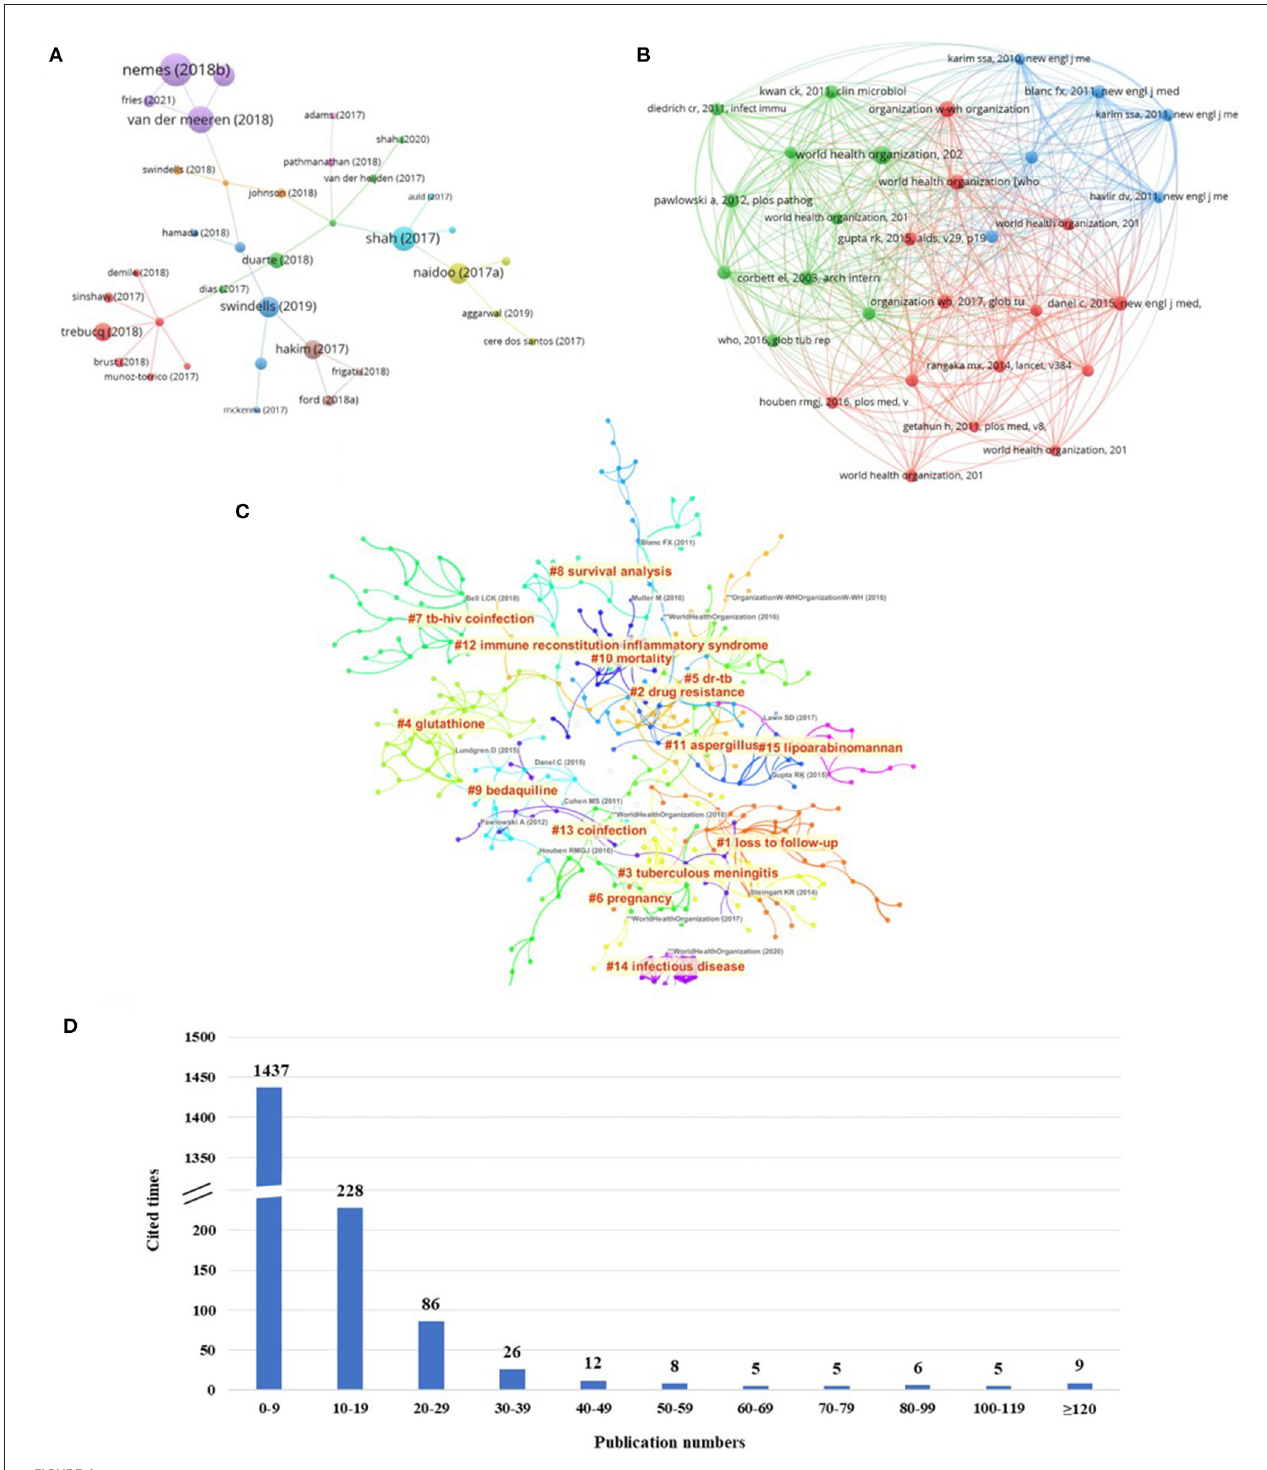
FIGURE4 Reference citations and RCA of HIV-MTB co-infection research. (A) Analysis of citation times of references on HIV-MTB co-infection. (B) Map of the analysis of co-cited references on HIV-MTB co-infection. (C) Map of RCA on HIV-MTB co-infection. (D) The cluster map of RCA on HIV-MTB co-infection. RCA, reference co-citation